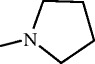
Synthetic scheme for the preparation of compounds 3a to 3 l.